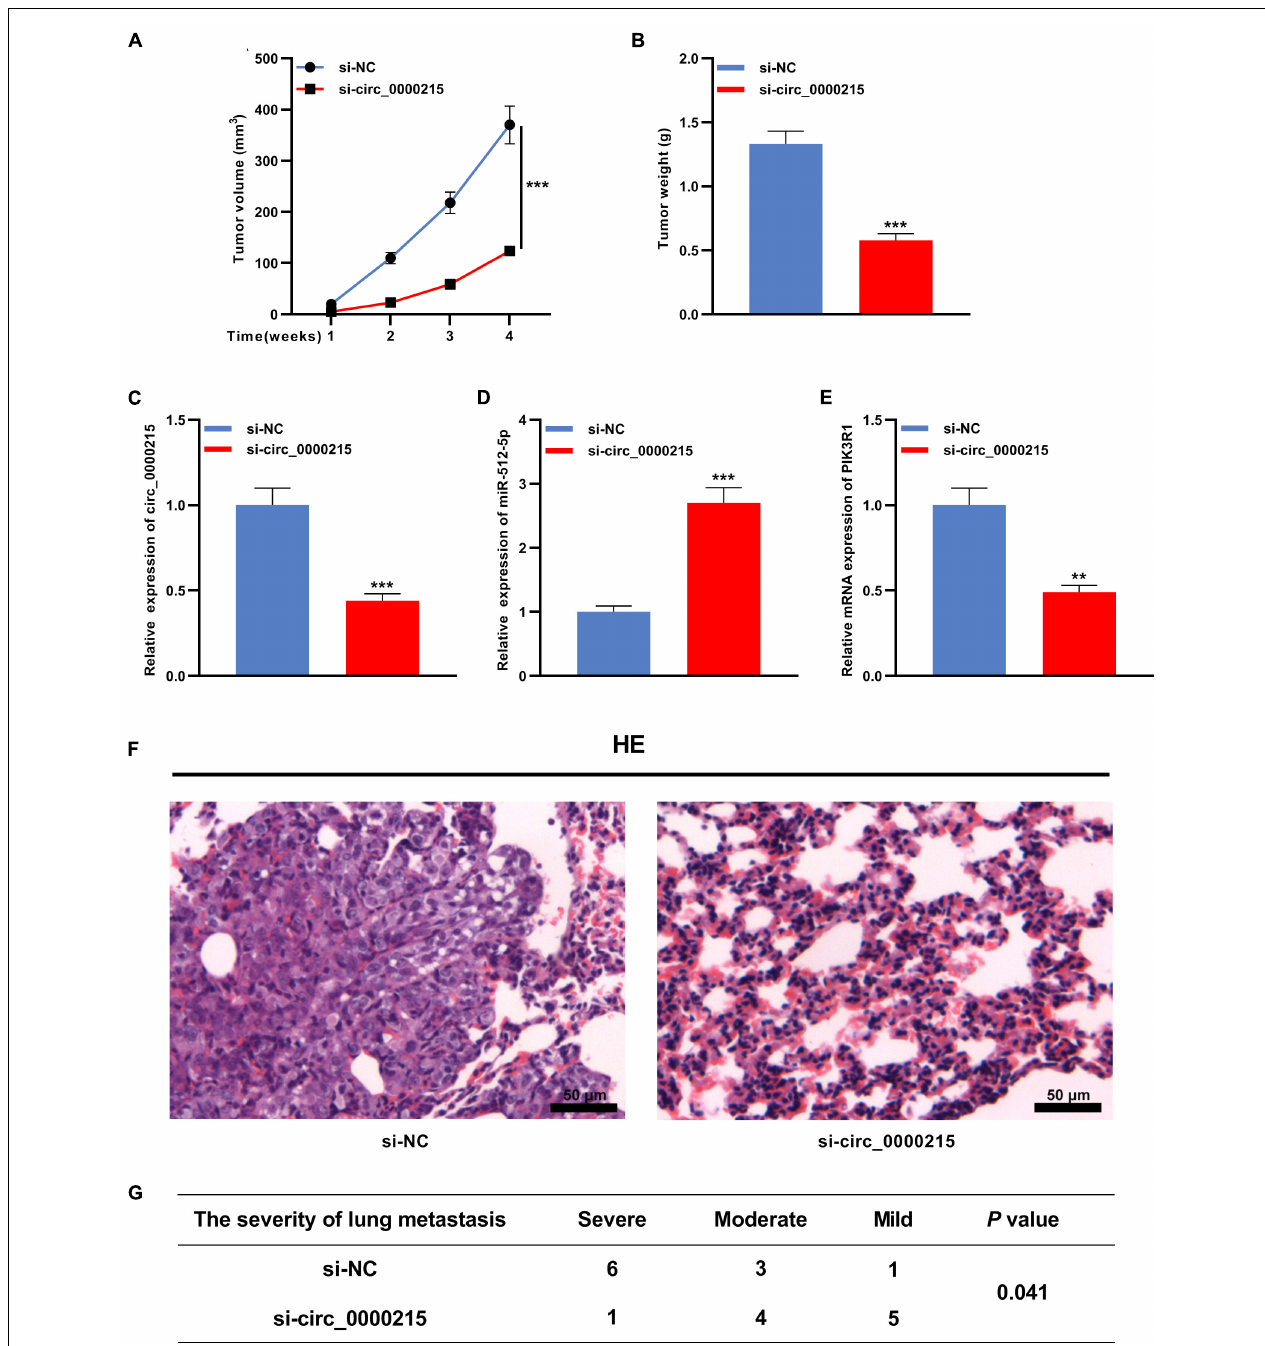
FIGURE 8 | Circ_0000215 enhances the growth and lung metastasis of NPC in vivo . (A,B) HONE1 cells transfected with sh-NC or sh-circ_0000215 were injected subcutaneously into nude mice ( n = 10 per group), and tumor growth curves (A) and tumor weights (B) were plotted. (C–E) qRT-PCR was employed to detect circ_0000215 (C) , miR-512-5p (D) , and PIK3R1 (E) expressions in tumor tissues. (F,G) HONE1 cells transfected with sh-NC or sh-circ_0000215 were injected into nude mice via tail vein ( n = 10 per group), and HE staining was utilized to detect the lung metastases of the mice. The significance of difference was determined by Student’s t -test or chip test.** P < 0.01, and *** P < 0.001. Data from three independent experiments were expressed as mean ± standard deviation.